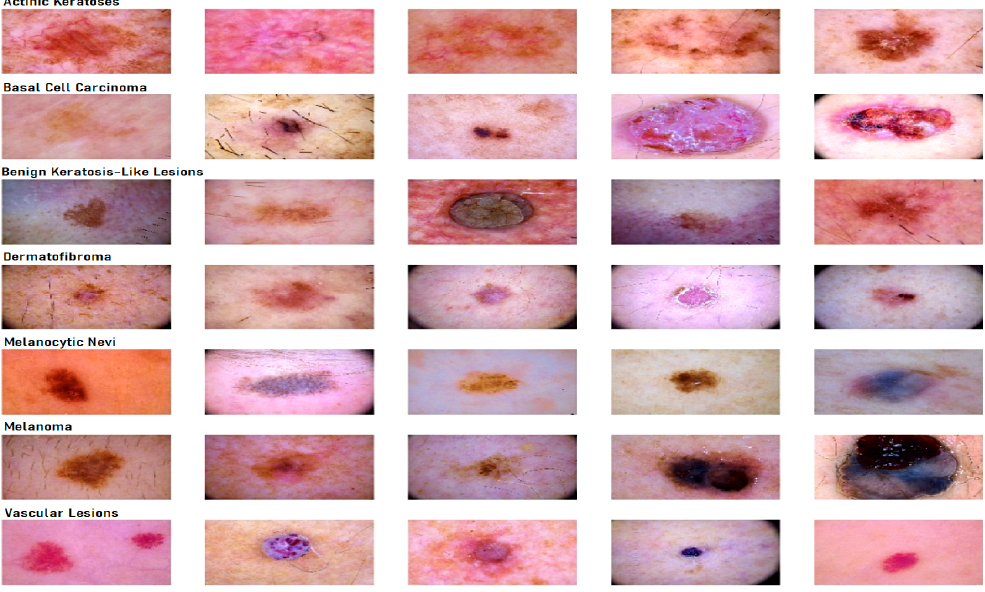
Figure 1. Seven different types of diseases caused from lesions.